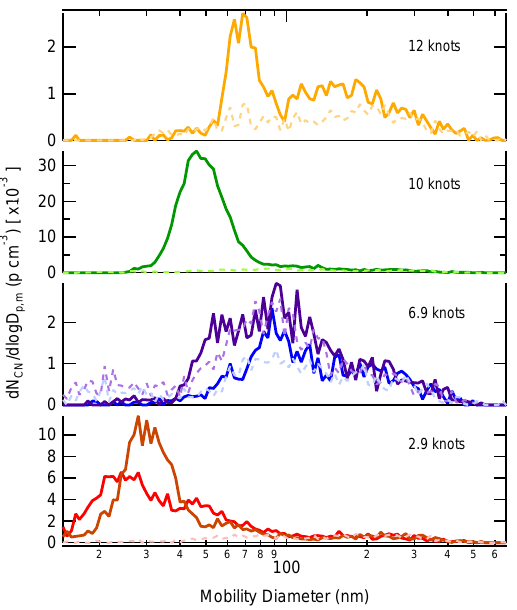
Fig. 3. Measured number-weighted particle mobility size distribu- tions during plume intercepts at different vessel speeds. The solid lines indicate the distributions measured in the plumes while the dashed lines indicate distributions measured adjacent to the plumes and represent approximate background size distributions. The abil- ity to distinguish plume distributions from background is not al- ways apparent due to limited (random) overlap of the SMPS scan- ning cycle with the plume occurrence. However, for the 2.9, 10.2 and 12knot intercepts a mode due to plume particles is clear. For the 2.9knot intercept, the plume was sufficiently long that two full SMPS scans were completed, which are shown as independent size